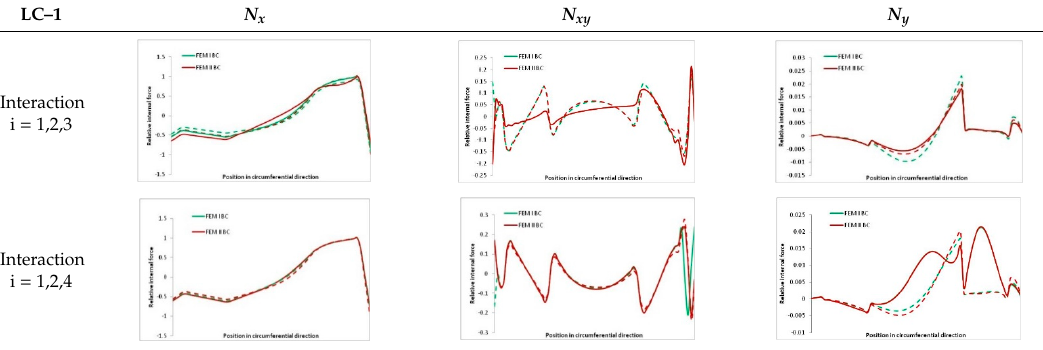
Table 15. Internal forces in LC–1 beam under the load corresponding to the first failure and the load-carrying capacity.